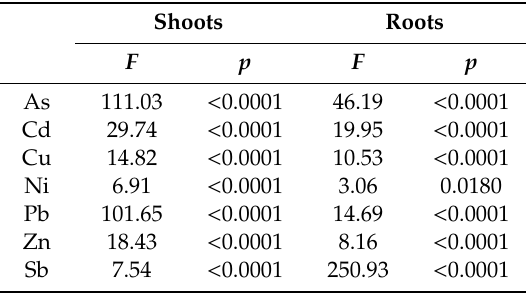
Table4. Resultsofvarianceanalysis(One-wayANOVA)comparingthedi ff erenceinmetalconcentration among species (dF =